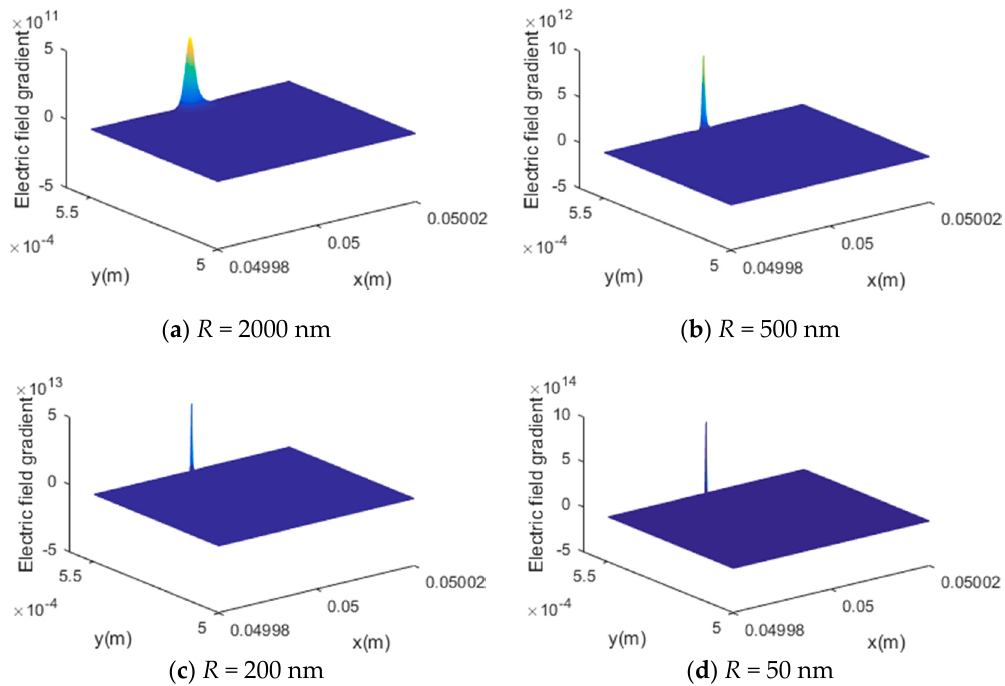
Figure 2. The effect of the AFM probe radius on the electric field gradient, ( a ) R = 2000 nm, Figure 2. The e ff ect of the AFM probe radius on the electric field gradient, ( a ) R = 2000 nm, ( b ) R = 500 nm, ( c ) R = 200 nm, ( d ) R = 50 nm.